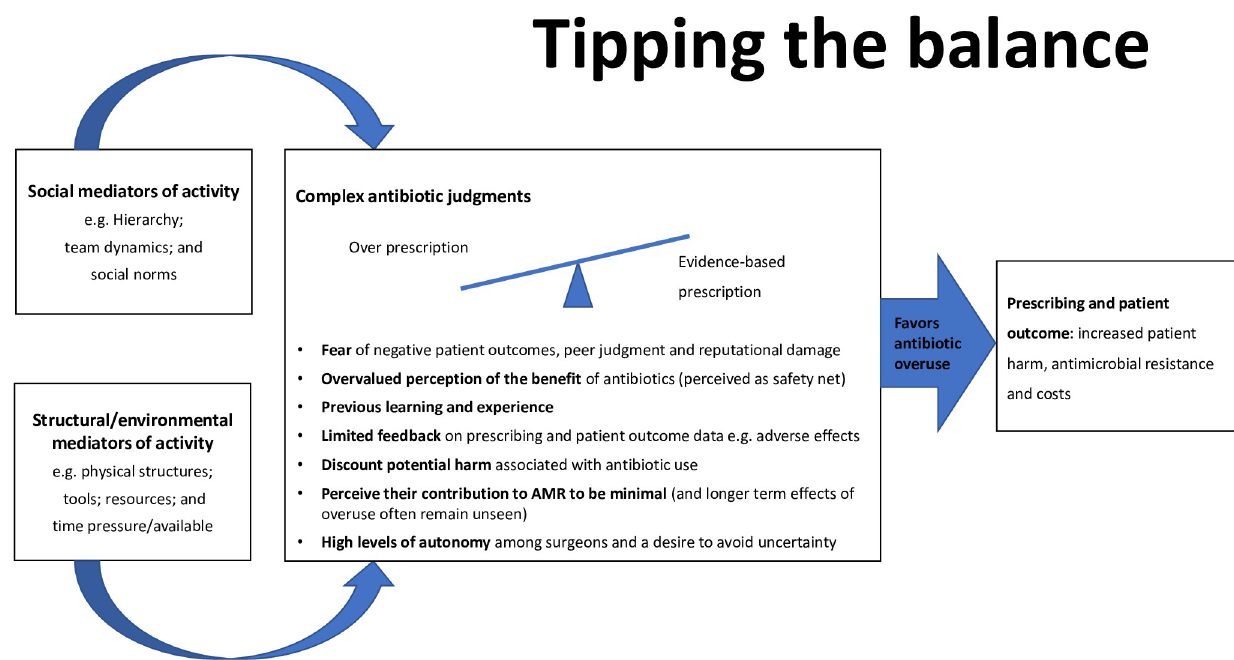
Fig 2. Conceptual model showing how social and structural mediators influence individual complex judgements about whether to prescribe antimicrobials for surgical patients, currently tipping the balance towards unnecessary antimicrobial use and resulting in increased patient harm, AMR and